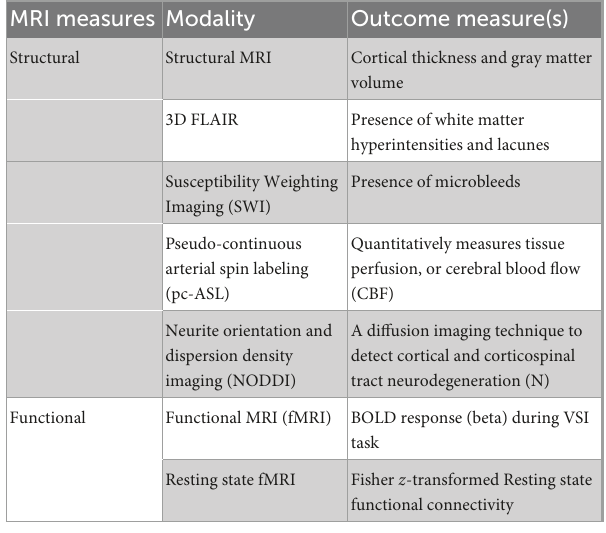
TABLE 3 List of Magnetic Resonance Imaging (MRI)